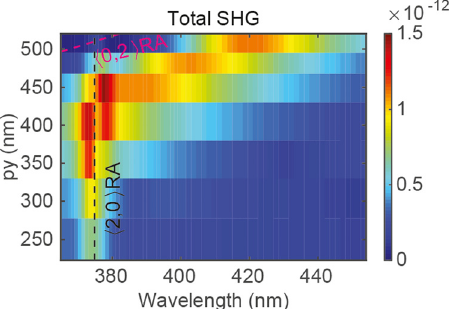
Figure 8: (Color online) Intensity of the second harmonic signal generated for different p y spacing in colormap plots. The dashed lines show the 〈 2 , 0 〉 and 〈 0 , 2 〉 Rayleigh anomaly